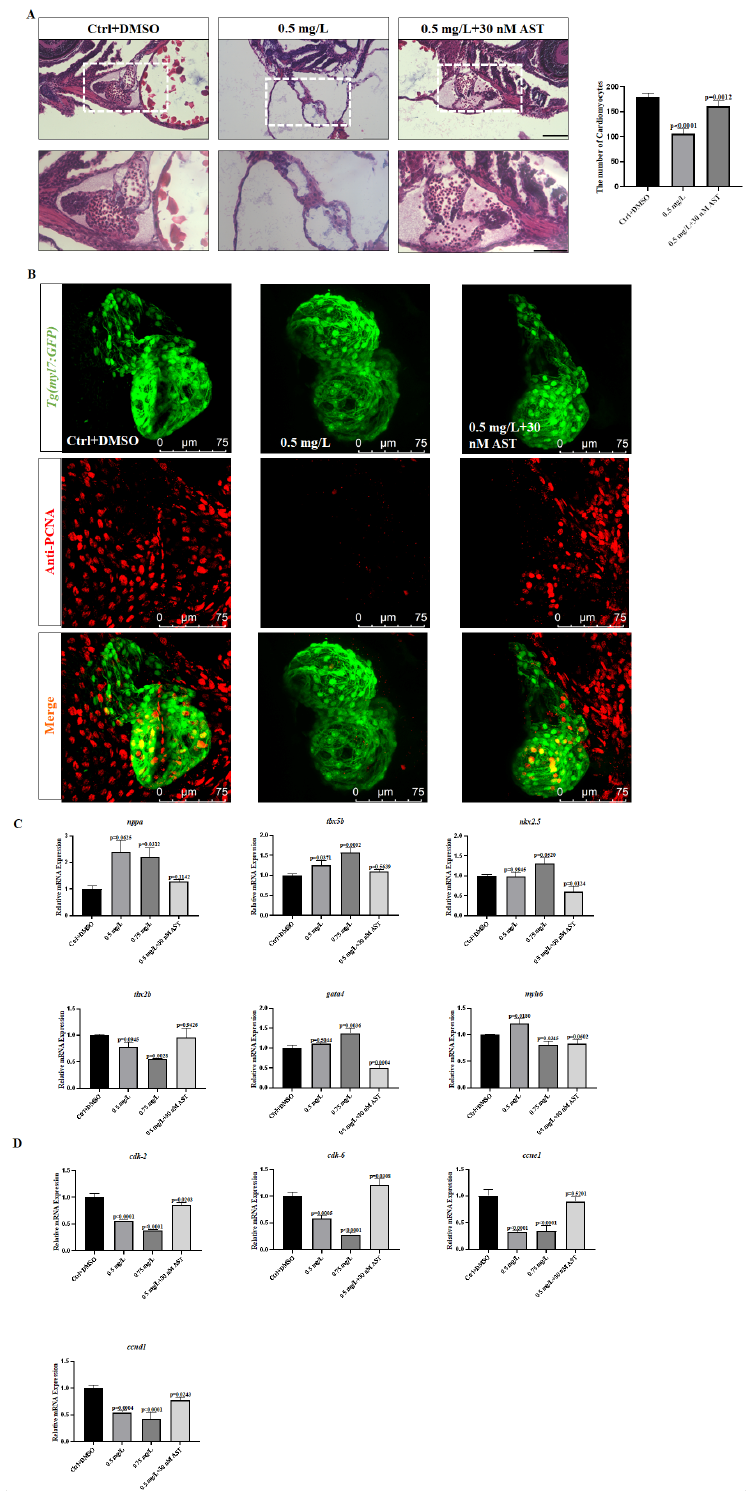
Toxics 2022 , 10 , x. https://doi.org/10.3390/xxxxx www.mdpi.com/journal/toxics Figure 5. Astaxanthin rescued the expression of genes related to heart and cell proliferation. ( A ). H & E staining images of control group, medium concentration group, and AST rescue medium concentration group. ( B ). The result of immunofluorescence staining after adding AST to rescue. ( C ). AST rescued heart-related gene expression. ( D ). AST rescued cell proliferation related Gene expression status. Each difference is a comparison between the control group and the treatment group. ( n = 20, Means ± SD. Scale bar: ( A ) 50 µ m/25 µ